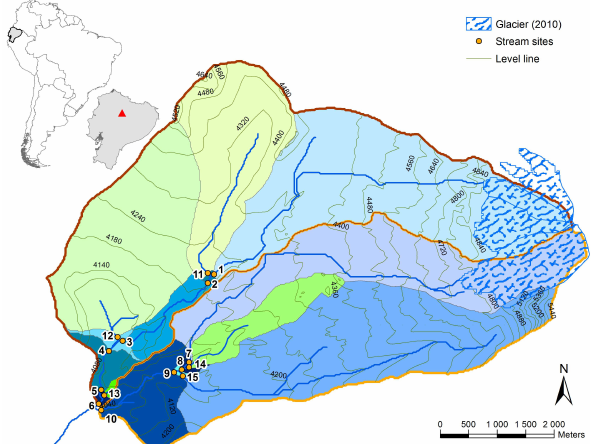
Fig. 1. Study area at the Antisana volcano, Ecuador. Stream sites are represented by orange circles. Catchment basins of all stream sites are represented by blue (glacier-fed stream sites) and green (supposedly non-glacial tributaries) polygons. Map was made us- ing ArcGIS (10.0), and catchment basins were defined using SAGA (2.0.8). The location of the Antisana volcano is indicated on the map of Ecuador by a red triangle. The catchments “Los Crespos” (including the catchments of stream sites 7 to 10, 14, and 15) and “Antisana 14 Glacier” (including the catchments of stream sites 1 to 6, and 11 to 13) are delimited by an orange and brown contour line, respectively.